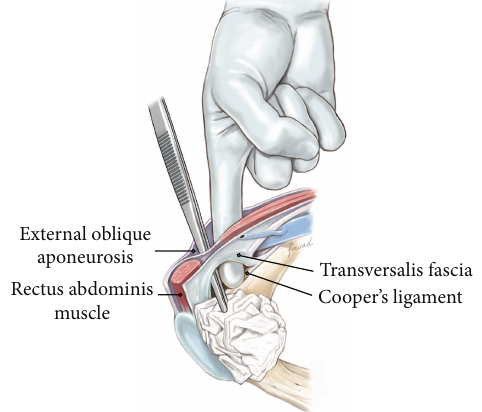
Figure 4: Blunt dissection using the finger will create the necessary surgical space for the operation.